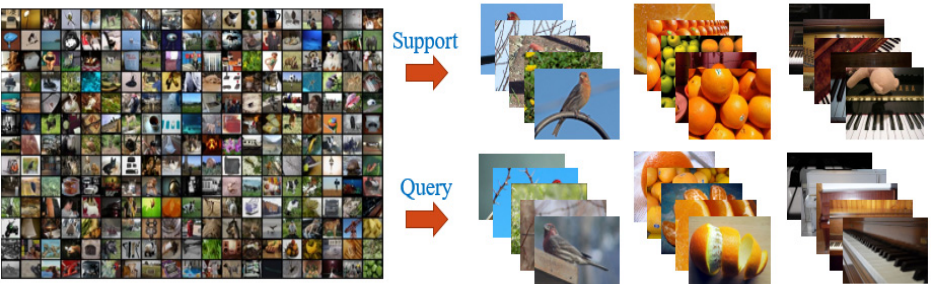
Figure 7. Schematic diagram of the selection method.